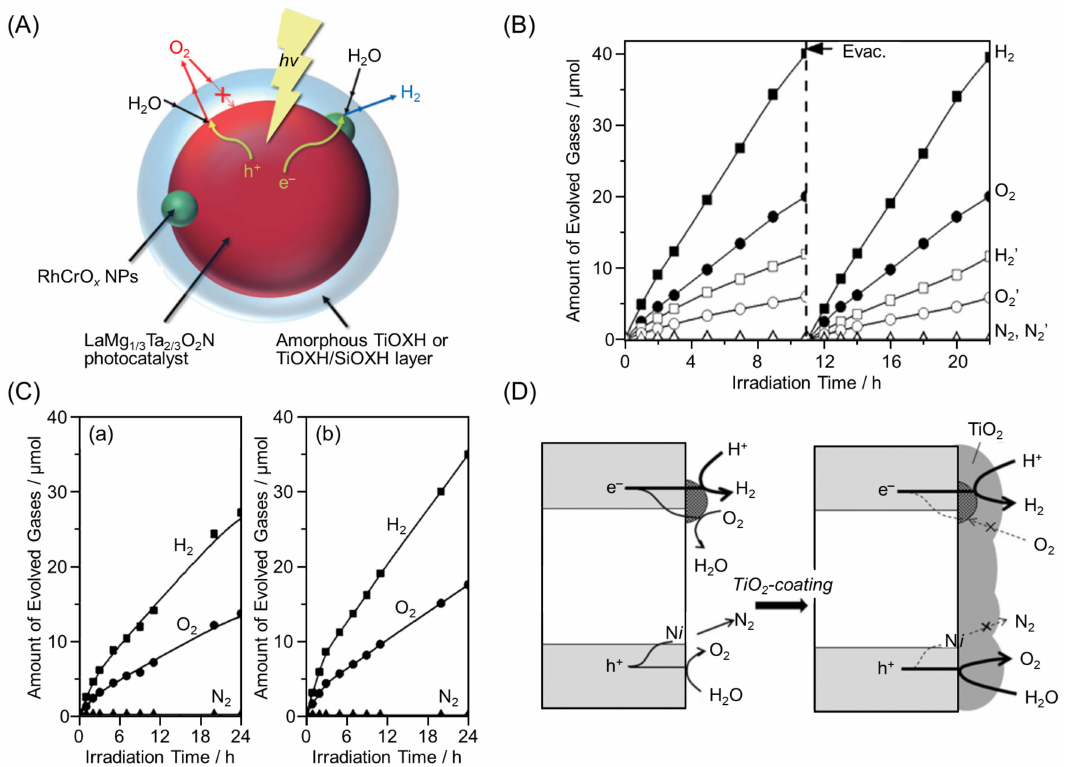
Figure 30. ( A ) Reaction mechanism for water splitting on a surface-coated photocatalyst. ( B ) Gas evolution during water splitting on TiOXH/SiOXH/RhCrO x NPs/LaMg 1/3 Ta 2/3 O 2 N under UV/Vis- light irradiation ( λ > 300 nm; filled symbols) and Vis-light irradiation alone ( λ > 420 nm; open symbols). Reaction conditions: Catalyst (0.2 g), reaction solvent (pure water, 250 mL), Xe lamp (300 W); a side-irradiation-type Pyrex reaction vessel was used. ( C ) Time courses of gas evolution on RhCrO x NPs/LaMg 1/3 Ta 2/3 O 2 N modified by different TiO 2 coating methods: ( a ) TiO 2 /H 2 O 2 and ( b ) TTIP/H 2 O 2 . Reaction conditions are the same as ( A ). ( D ) Schematic of the functions of the cocatalyst (RhCrO x ) and the coating layer (TiO 2 ). N, unstable surface nitrogen; N i , nitrogen at the interface. Reproduced with permission from references [234,235]. Copyright 2015 Wiley-VCH and 2016